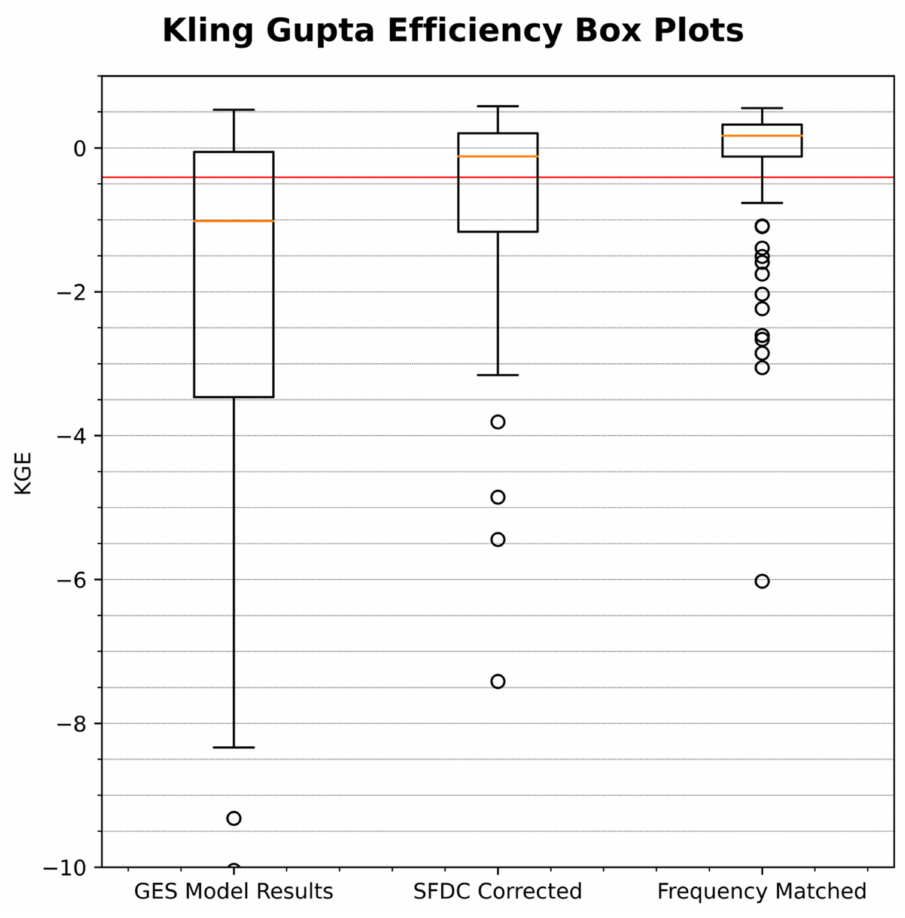
Figure 8. Box plots of KGE results in the Magdalena River basin for each test group. A horizontal red line indicates a KGE of − 0.41, which corresponds to the KGE of a constant mean observed value